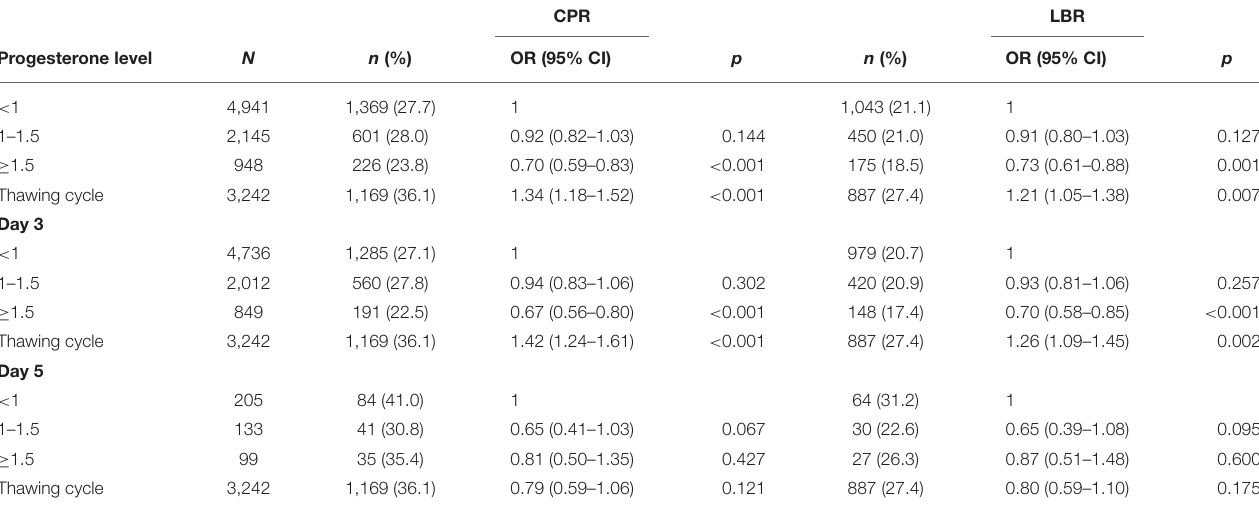
TABLE 4 | Comparison between women who underwent fresh embryo transfer, both in day 3 (D3) and day 5 (D5) groups, and those who underwent frozen-thawed cycles (independently of D3 or D5 embryos): influence of P levels on clinical pregnancy rate (CPR) and live birth rate (LBR) (OR are corrected by woman age, number of retrieved oocytes, and number of transferred